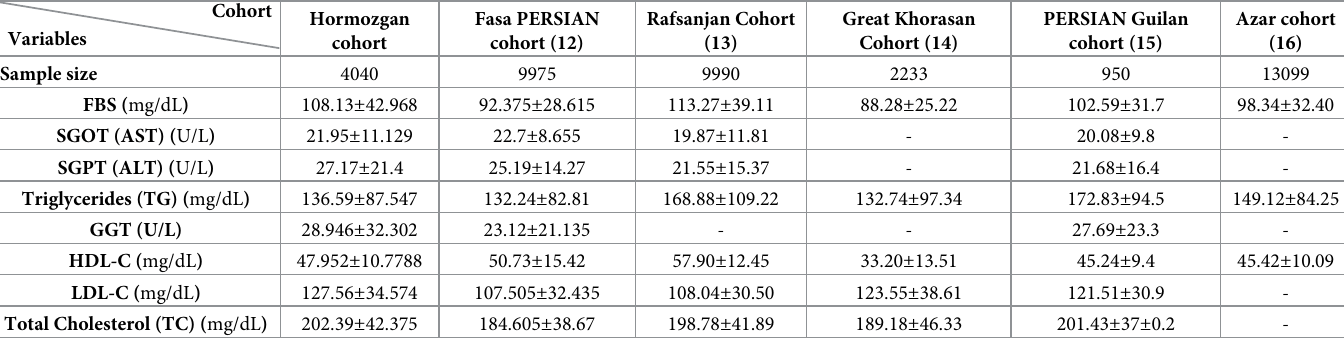
Table 1. Biochemical variables in various studies of PERSIAN cohort study.